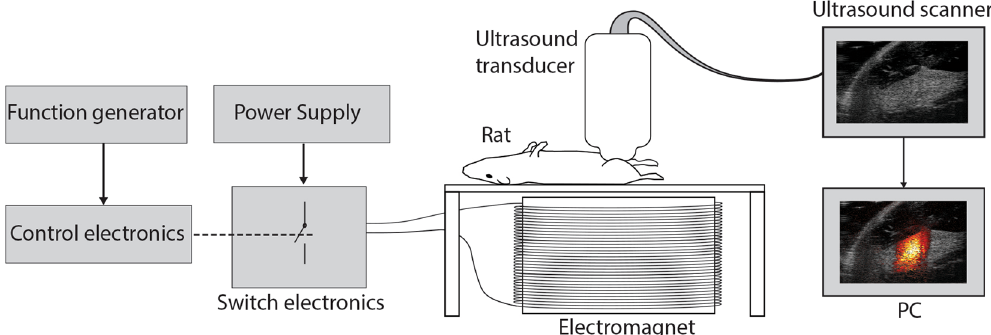
Figure 6. Magnetomotive ultrasound experimental setup. The lymph node in the animal’s knee was placed over the electromagnet. An electrical signal produced by a function generator was used to switch a power source at a frequency of 5 Hz, producing and a time-varying magnetic field of 5 Hz after application to the electromagnet. The nanoparticles in the sentinel lymph node were thereby set in motion and consequently their surrounding tissues. An ultrasound scanner registered the tissue movement, and post-signal processing of the ultrasound data extracted the magnetomotive displacement. The animal and the transducer were decoupled from the electromagnet to avoid mechanical disturbance from the